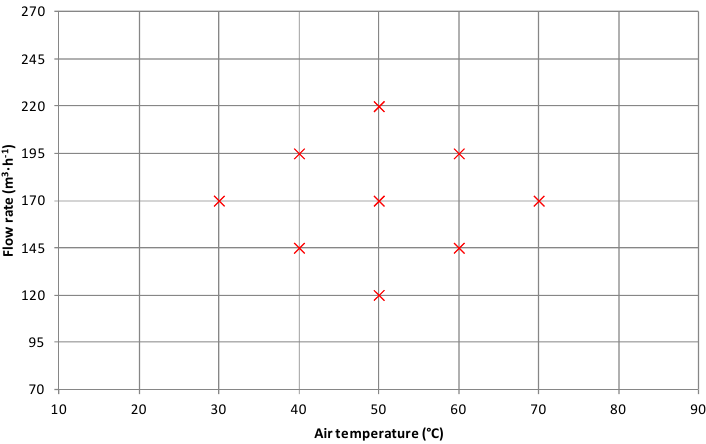
Figure 3. Experimental tests according to the design of experiments Figure3. Experimental tests according to the design of experiments (DOE).